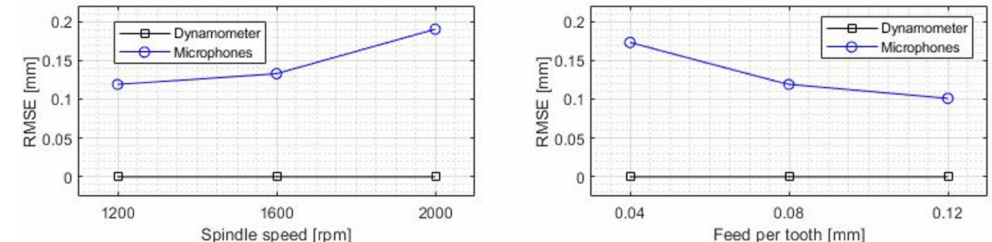
Figure 9. Mean value of the mean square error for each combination of machining parameters.